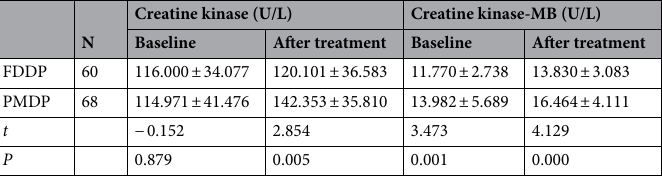
Table 2. Results of serum levels of CK and CK-MB in FDDP and PMDP groups. Variables are shown as the mean ±